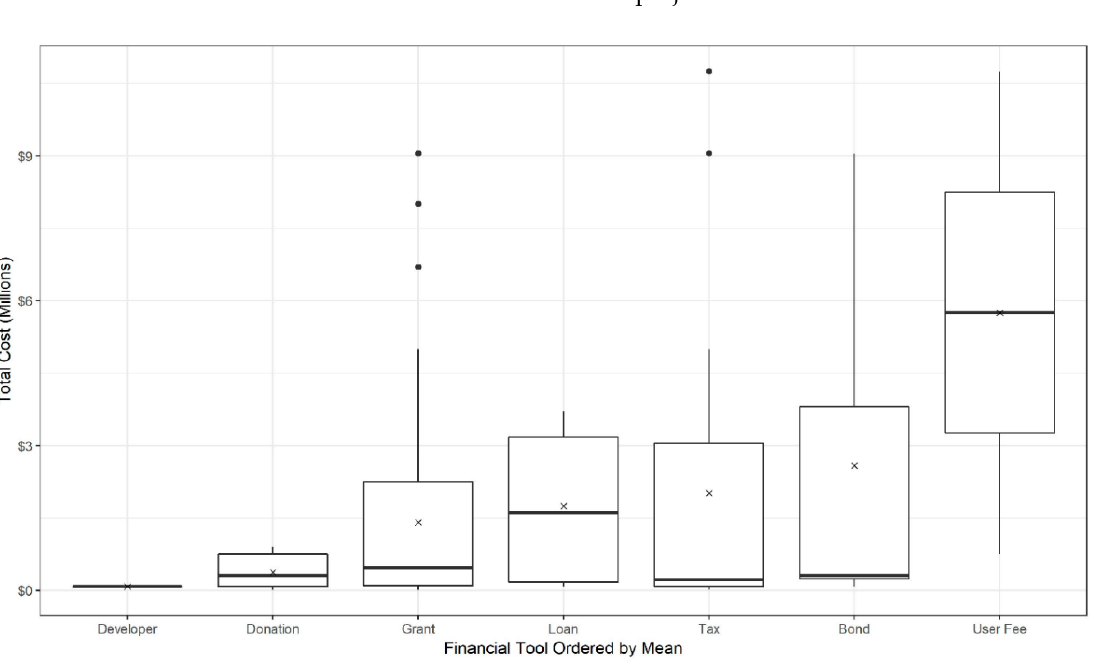
Figure 3. Total project cost by financial tool used to finance the project. Note: Only 102 cases (about 23%) provided information on the specific tools used. Projects often included more than one financial tool but did not specify the breakdown of how much funding came from each tool; this distribution represents the total cost of each project that used the given financial tool for at least a portion of the financing. The boxes represent the interquartile range (IQR), the bars within the boxes represent the median, the points marked with an “ × ” represent the mean, and the dots are the outliers defined as 1.5 times the IQR in either direction.